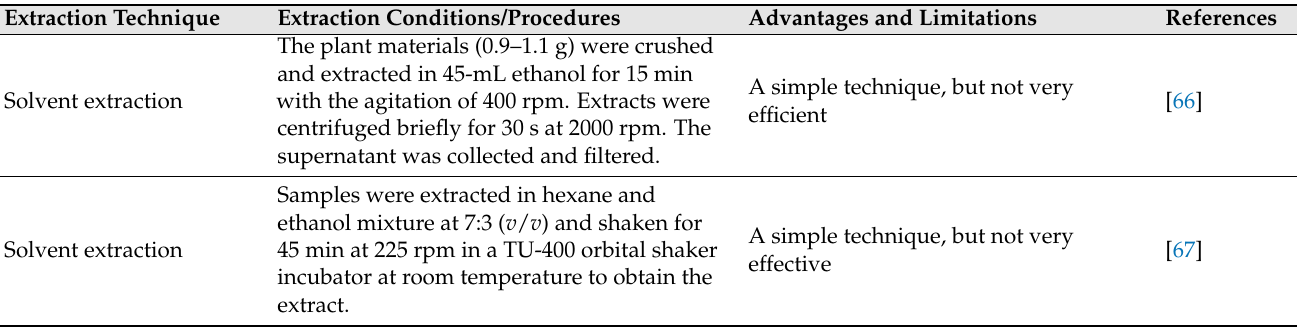
Table 1. Extraction of phytochemicals from Cannabis